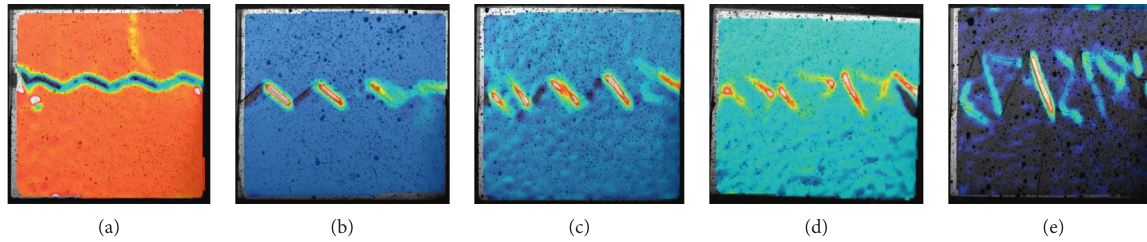
Figure 5: Shear strain field with different undulating heights. (a) B-5. (b) B-10. (c) B-15. (d) B-20. (e) B-30.